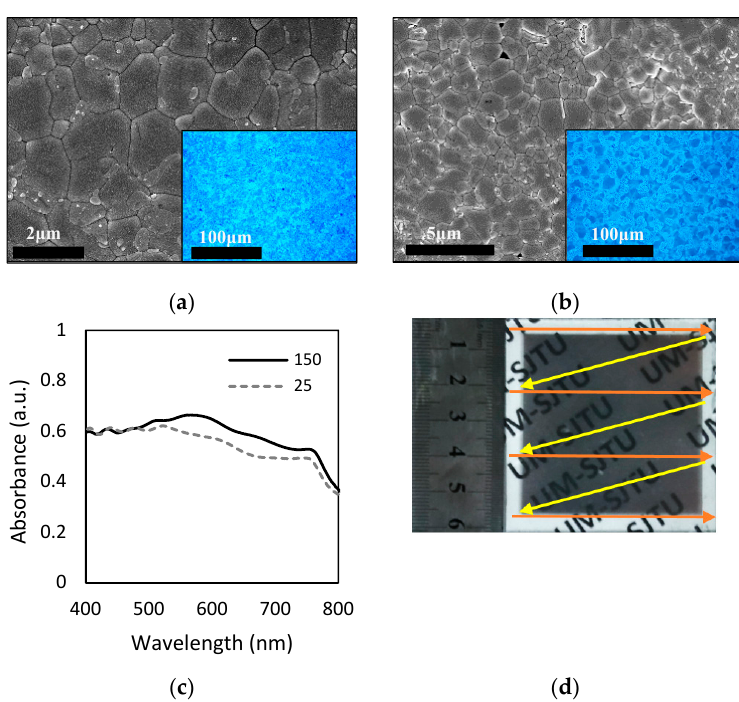
Figure 11. SEM and optical (inset) images of spray-on perovskite films made at substrate temperature of ( a ) 25 °C and ( b ) 150 °C. ( c ) absorbance spectra of perovskite films sprayed on FTO-coated glass kept at 150 °C; ( d ) the spray-on film deposited on the hotplate kept at 150 °C and the deposition pattern based on a zigzag movement of the spray nozzle over the substrate. The films were made at optimum condition of 100 spray passes using a 10 wt.% solution concentration.